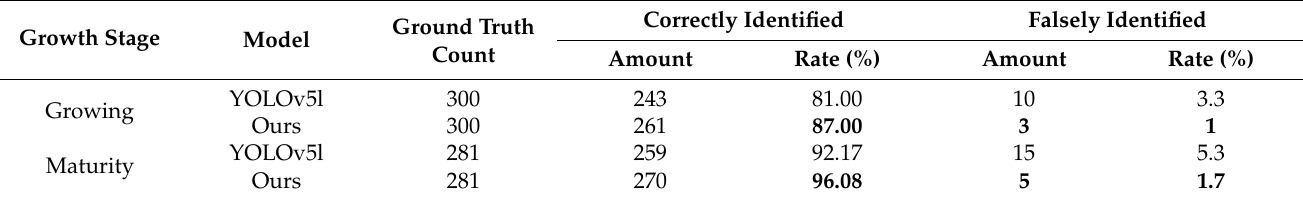
Table 4. The comparison results of our improved model and YOLOv5l in detecting citrus fruits under different growth periods.